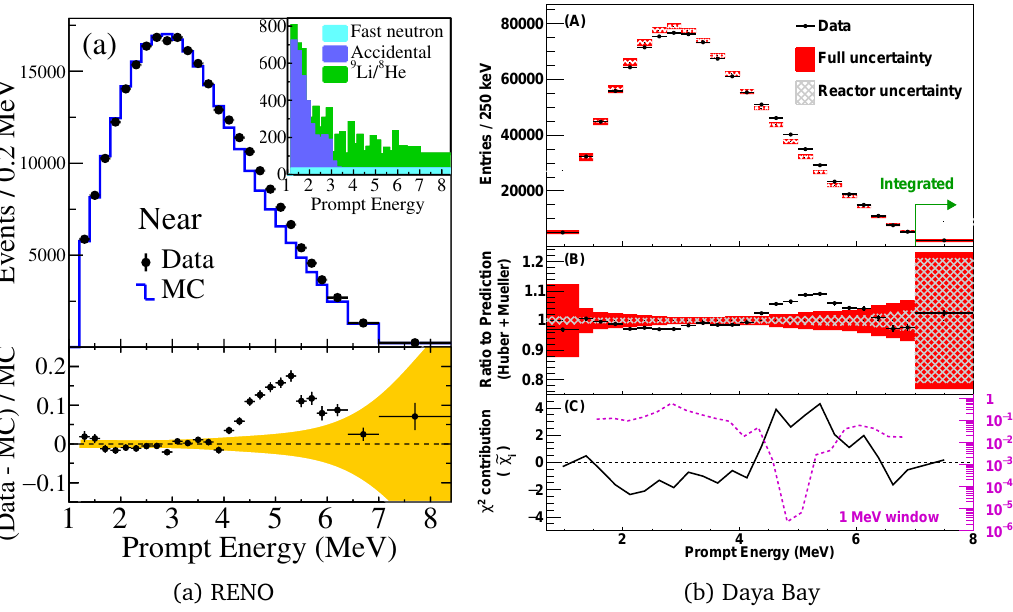
Figure 5: 5 MeV bump as measured by the RENO [ 16 ] and Daya Bay [ 18 ] collabora-